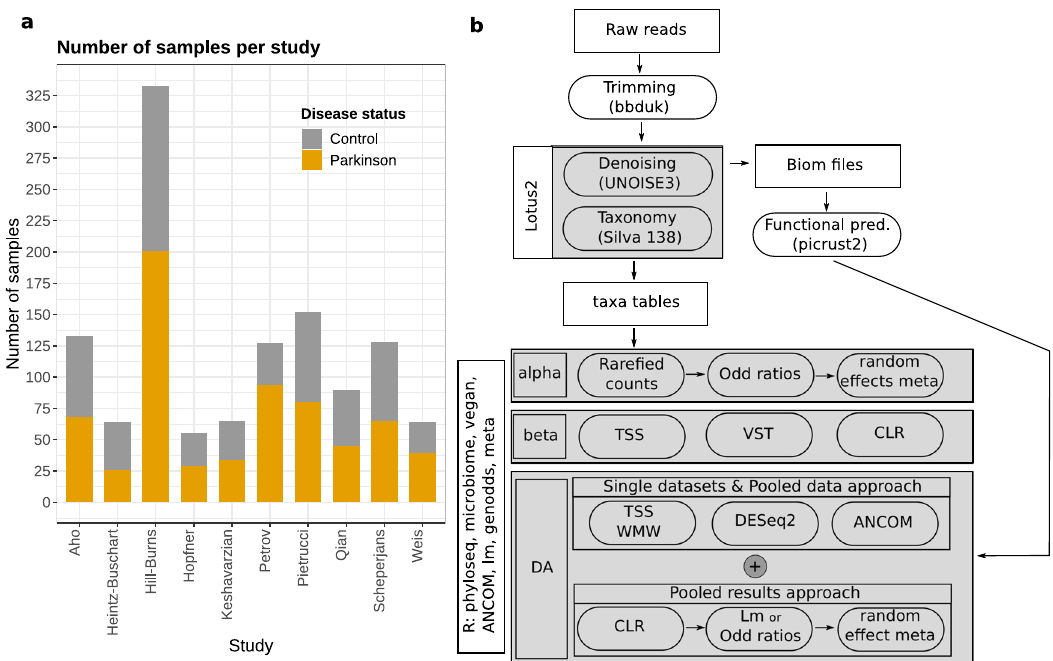
Fig. 1 Sample distribution across studies and bioinformatic work fl ow adopted in our study. a The number of control and PD samples refers to the data that could be recovered from the Sequence Read Archive (SRA) or the European Nucleotide Archive (ENA) and passed the quality fi ltering we applied. b Overview of the bioinformatic work fl ow adopted in our study. TSS total sum scaling, VST variance stabilizing transformation, CLR centered log ratios, WMW Wilcoxon – Mann – Whitney test, ANCOM analysis of the composition of microbiomes, lm linear models, genodds Agresti ’ s generalized odd ratios, meta random-effect